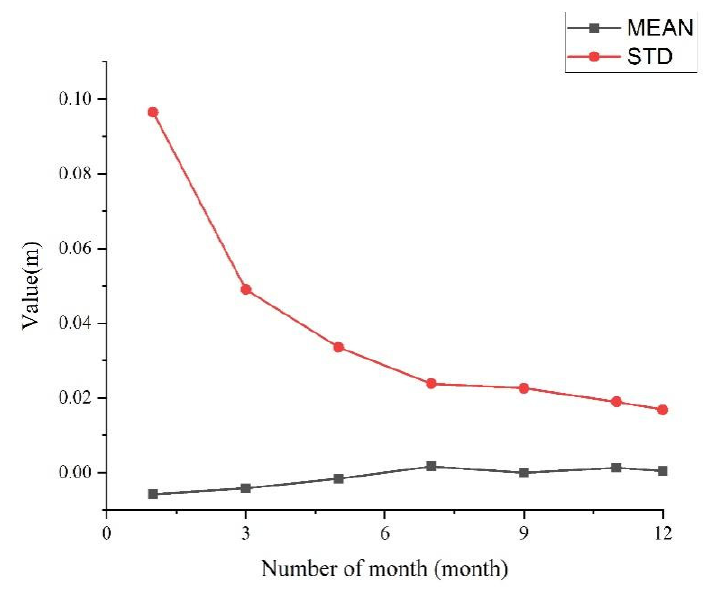
Figure 16. Variation of the statistics with time length.